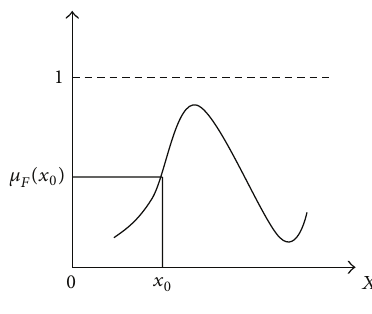
Figure 2: Fuzzy membership function.